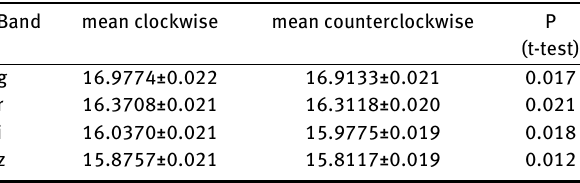
Table 6. Mean Kron magnitude of clockwise and counterclockwise Pan-STARRS galaxies in the field centered at the COSMOS field.